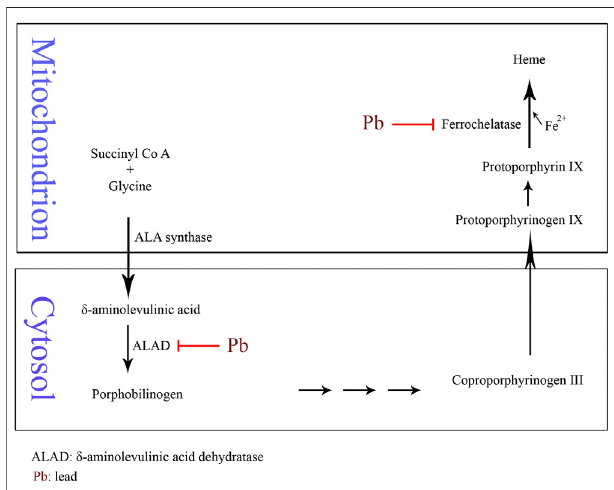
FIGURE 1 | Schematic of Pb-induced anemia via the inhibition of δ -aminolevulinic acid dehydratase and ferrochelatase enzymes in heme